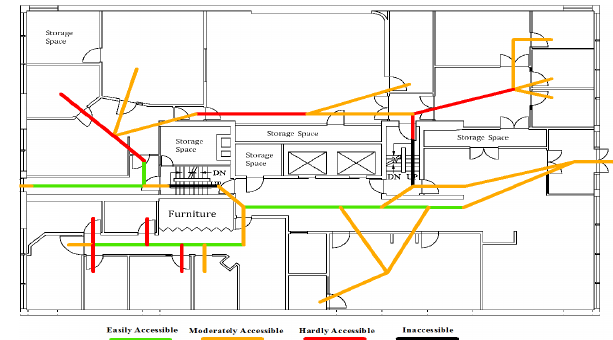
Figure 9. Heatmap of the accessible routes in the first floor of a building.